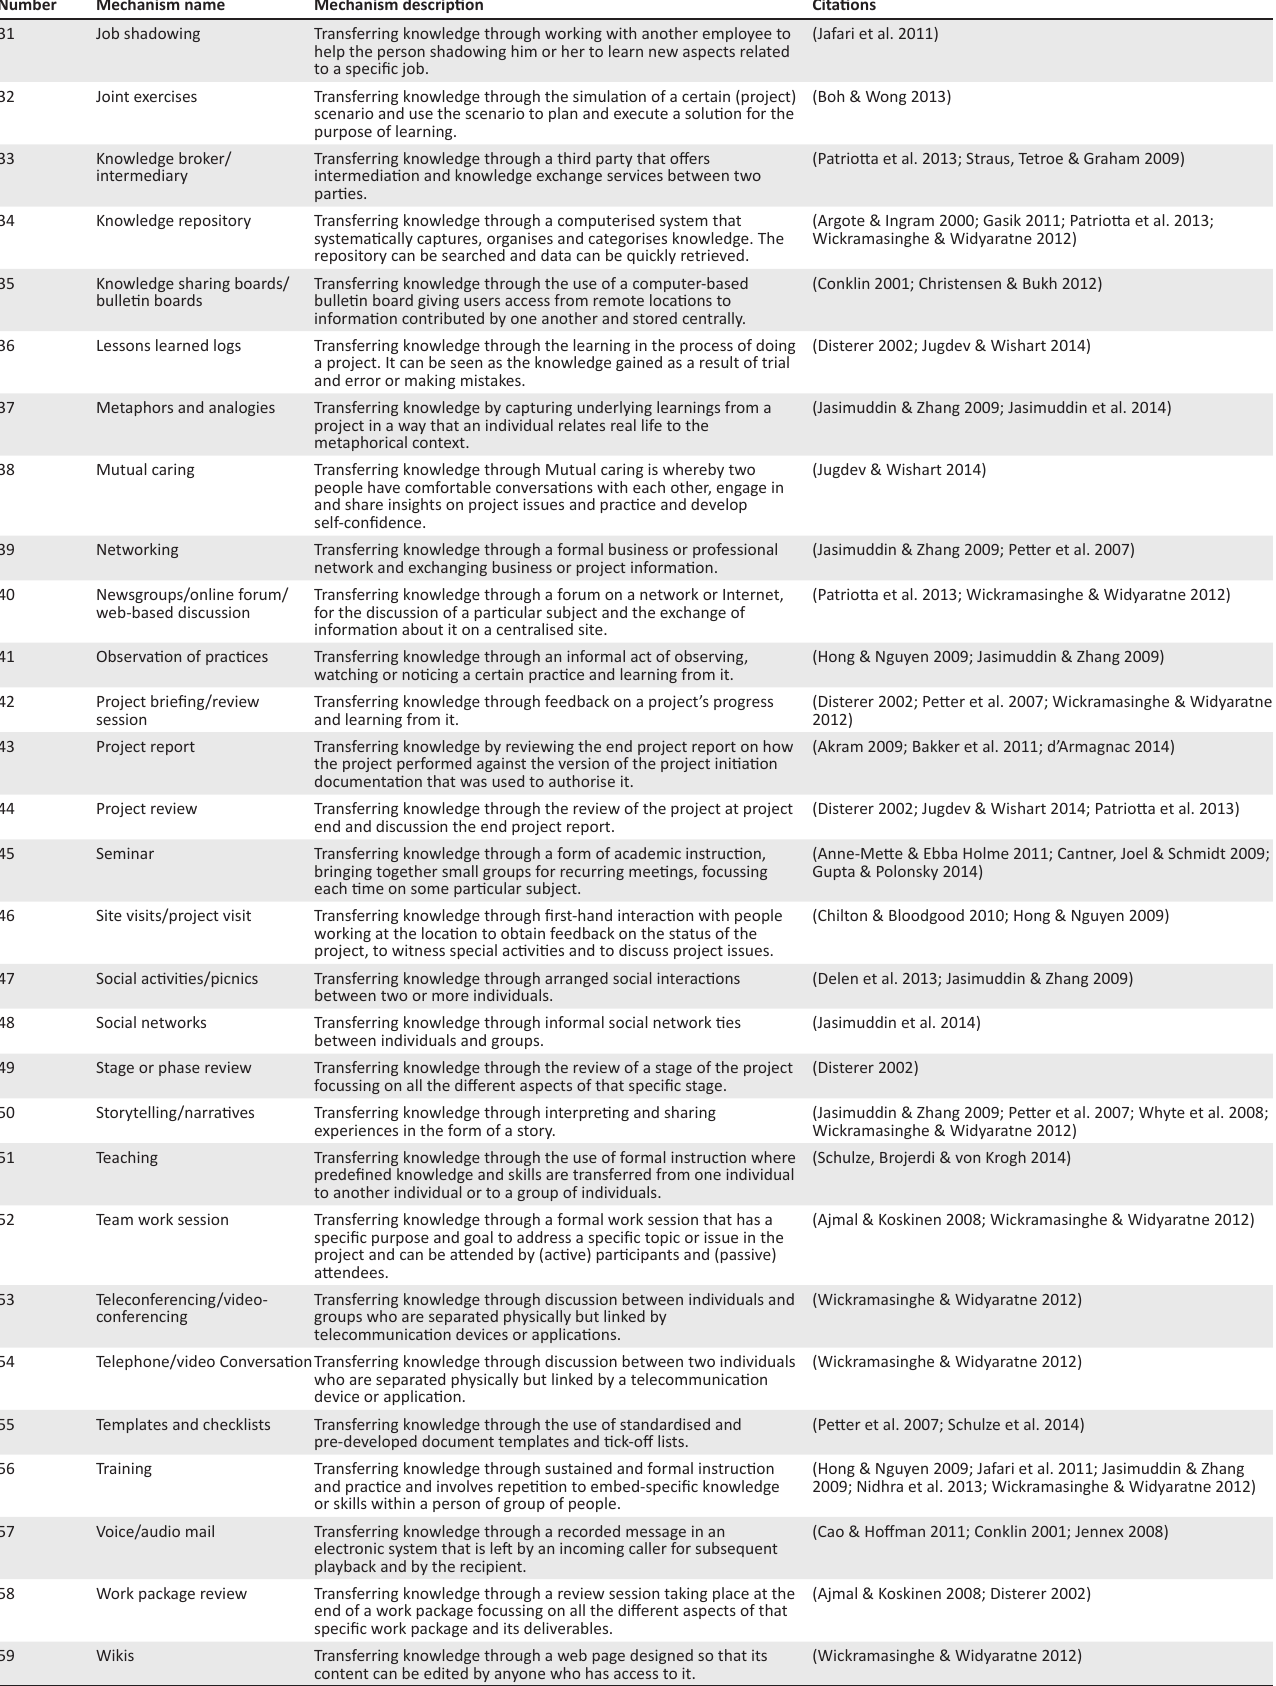
TABLE 1-A1 (Continues...): Identified knowledge transfer